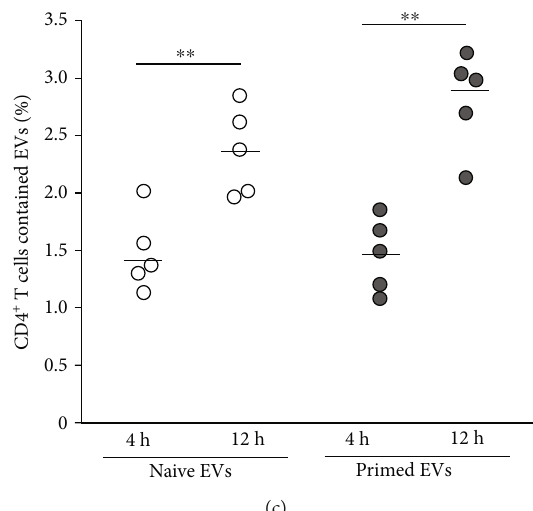
Figure 11: Incorporation of cADSC-EVs into stimulated T cells. (a) Immuno fl uorescence staining of labeled EVs and T cells stimulated with ConA. cADSC-EVs were labeled by Vybrant DiI (red) and nuclei were stained by DAPI (blue). (b) Flow cytometric detection of cADSC-EVs incorporated into CD4 + T cells (gated in red square). (c) Comparison of the population of CD4 + T cells that contained cADSC-EVs at 4 and 12 hours after coculture of stimulated PBMCs with 1 μ g/ml cADSC-EVs. The solid line indicates the average. ∗∗ P < 0 : 01 , between 4 and